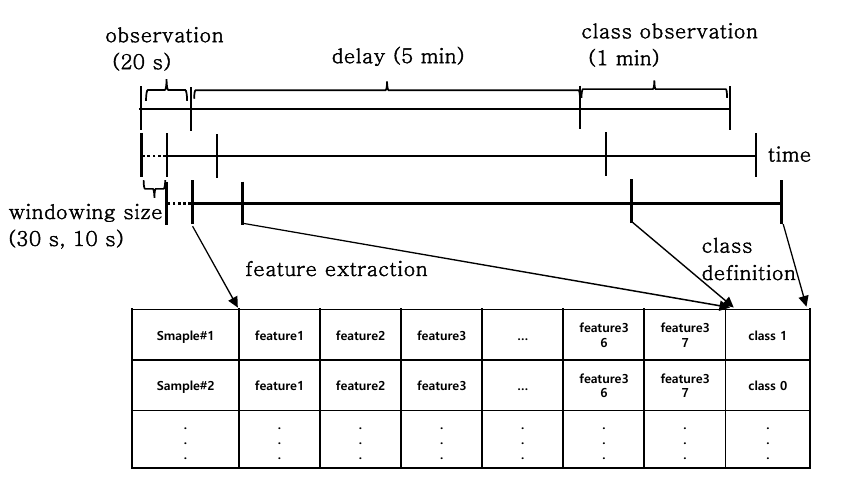
Figure 1. Sample generation process with an observation, delay, and class observation period. The observation period is how long feature generation can be observed, the delay is how far future events can be predicted, and the class observation is how long the event can be recognized.